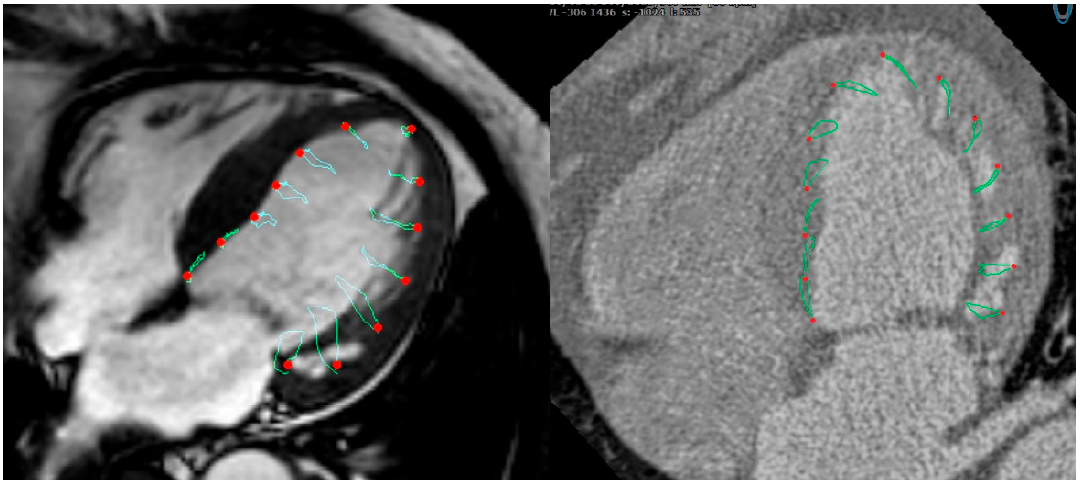
Figure 3. Assessment of GLS from the four-chamber long-axis (LAX) view in the same subject using CMR-FT ( left ) and CT-FT ( right ). J. Clin. Med. 2019 , 8 , x FOR PEER REVIEW